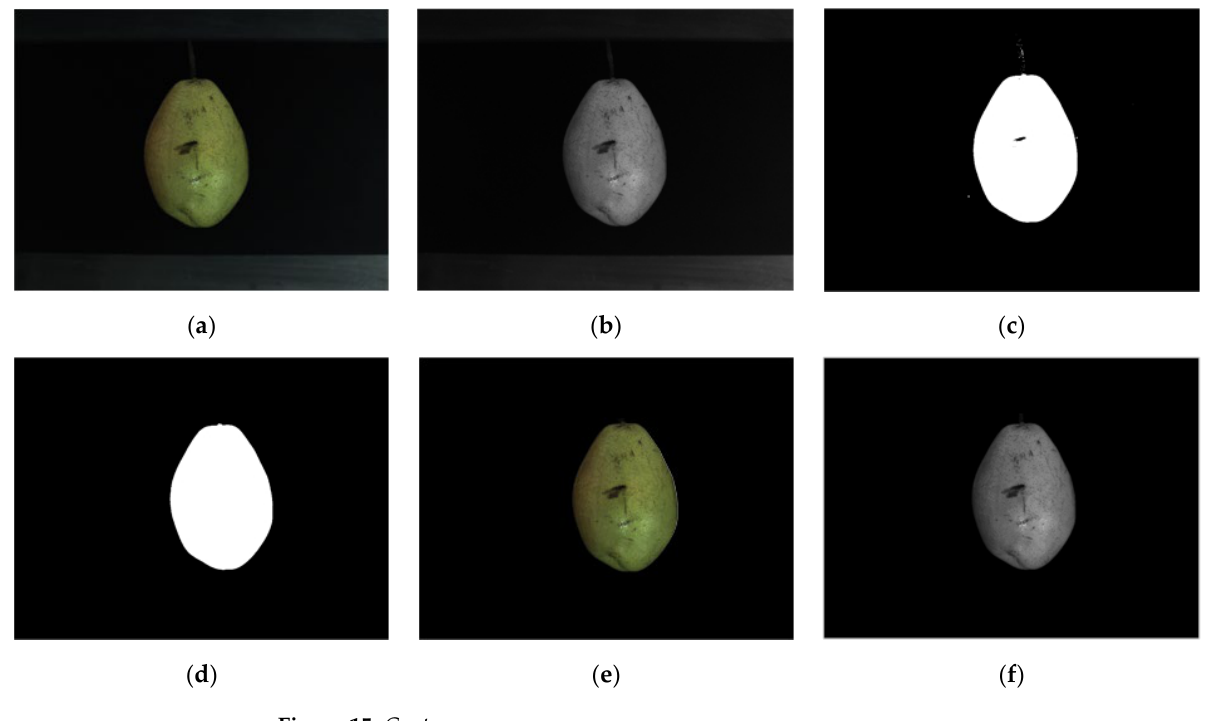
( i ) Figure 15. Image preprocessing process. ( a ) The original image. ( b ) Grayscale image of original im- age. ( c ) Pear contour image after threshold segmentation. ( d ) Pear contour image after morpholog- ical processing. ( e ) Segmented pear surface image. ( f ) Grayscale image of pear surface image. ( g ) Pear surface defect contour image after threshold segmentation. ( h ) Pear surface defect contour im- age after morphological processing and contour screening. ( i ) Pear surface defect image obtained after segmentation (contour indicated by red line). In the above image preprocessing process, the pear surface area image obtained by the first threshold segmentation can be used to analyze the pear shape and color features. The pear defect area image obtained by the second threshold segmentation can further analyze the pear surface defect features. 3.3. Feature Analysis The symmetry and quasi-rectangularity features of pear shape grading index were extracted. The R and G channel mean and variance features were extracted for the color grading index, and the ASM, contrast, IDM and entropy in the GLCM features were ex- tracted for the pear surface defect grading index. If the extracted features perform well, they can produce a good distinction between different categories under the grading in- dexes. For pear shape features, the symmetry feature comparison of the standard shape as well as the eccentric shape and the quasi-rectangularity feature comparison of the